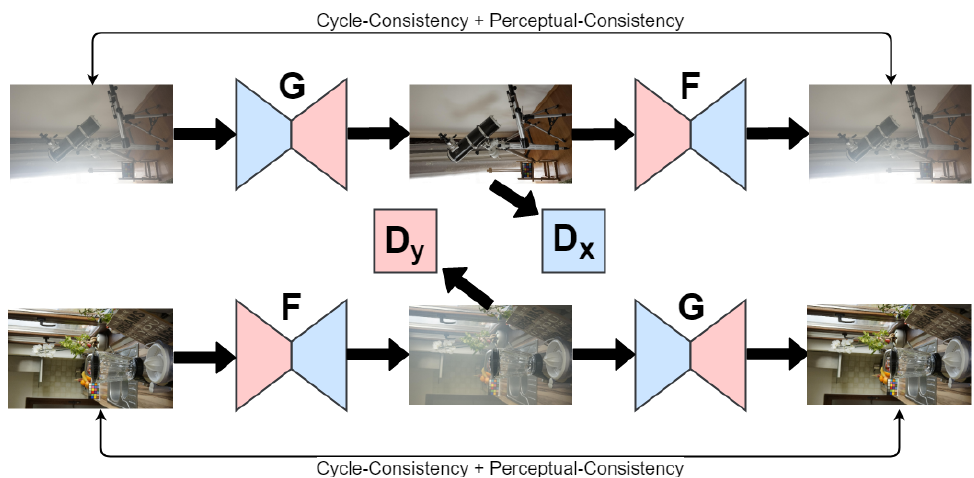
Figure 10. The architecture of the Cycle-Dehaze Model [143]. G and F are the generators, and D_x and D_y the